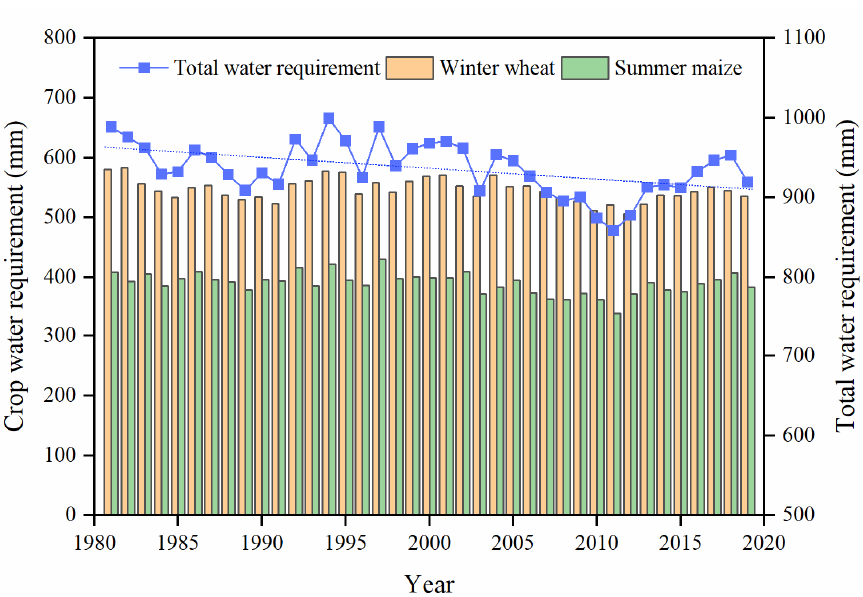
Figure 2. Variation of crop water requirement of winter wheat and summer maize from 1981 to 2019 in the lower reaches of the Yellow River Basin.